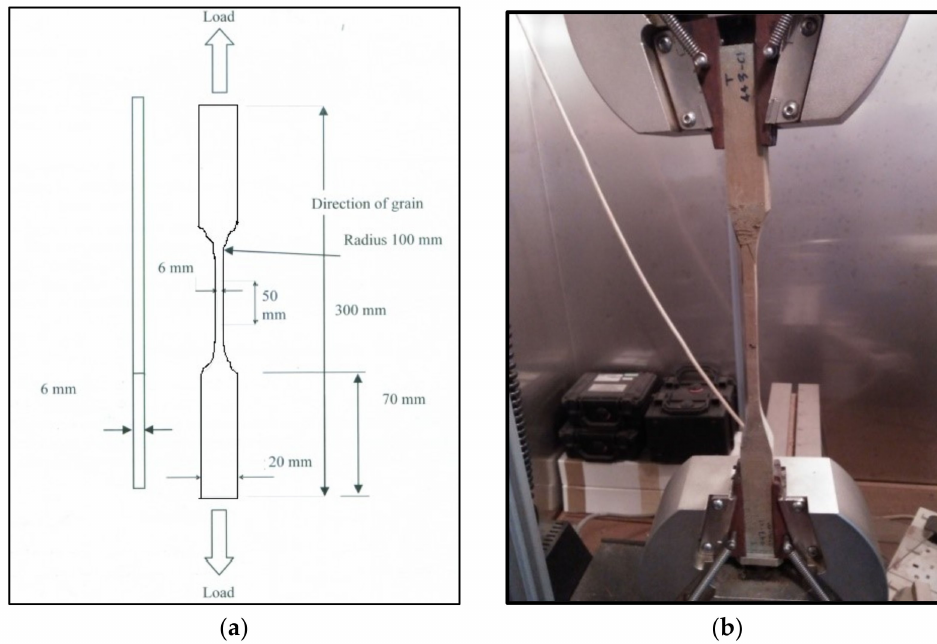
Figure 4. ( a ) Tension parallel to grain test sample. ( b ) Measuring of the tension parallel to grain of an Acacia hybrid sample with universal testing machine Instron 5569, Norwood, MA, USA.